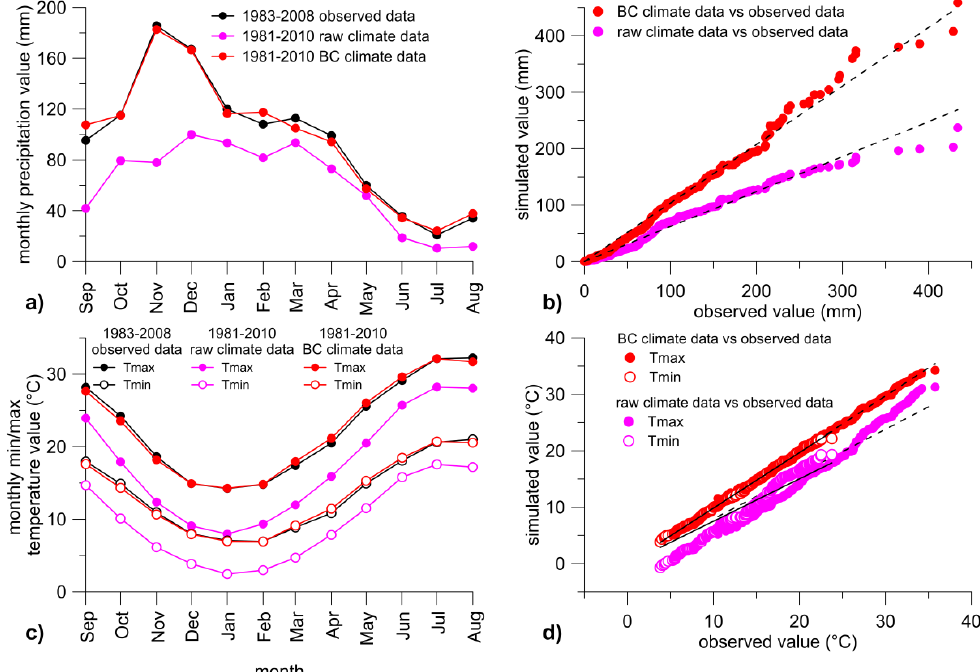
Figure 4. ( a ) Monthly cumulative precipitation values: observed (black), provided by a raw (magenta) or bias-corrected (red) CSC; ( b ) comparison between sorted time series of monthly precipitation (1983-2008) for observed vs values provided by raw (magenta) or bias-corrected (red) climate models; black dashed lines identify regression lines; ( c ) monthly temperature values: observed (black), provided by a raw (pink) or bias-corrected (red) CSC; minimum temperatures are represented by white dots, and the maximum by filled dots; ( d ) comparison between sorted time series of monthly temperature (1983–2008) for observed vs values provided by raw (magenta) or bias-corrected (red) climate models; filled dots are used for maximum temperature and white dots for minimum temperature black dashed (continuous) lines identify regression lines for maximum temperature.